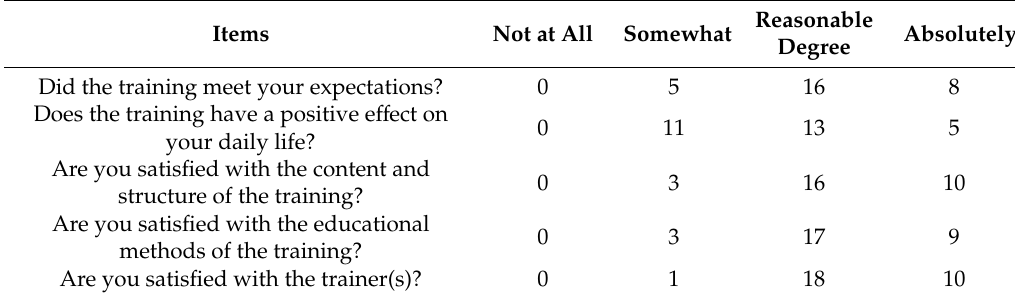
Table 2. The participants’ evaluation of the MBSR